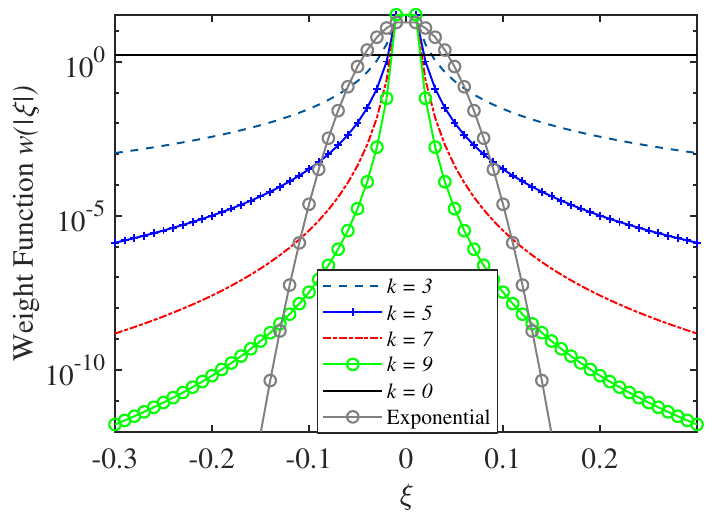
) (24) with different parameter k , exponential weight function is ξ | |